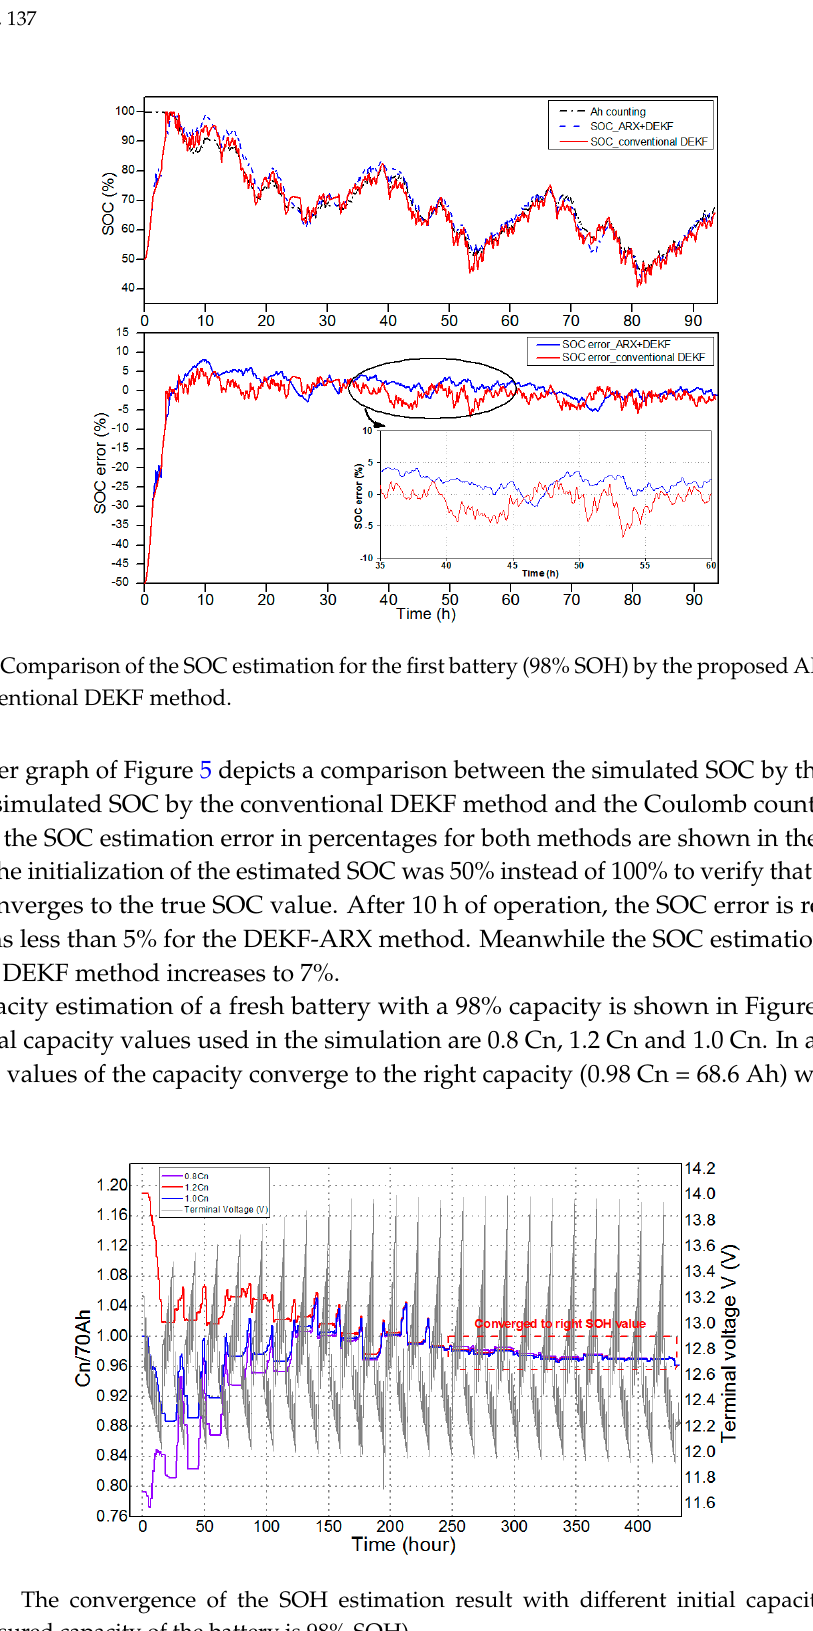
Figure 4. Zoomed in version of Figure 3.